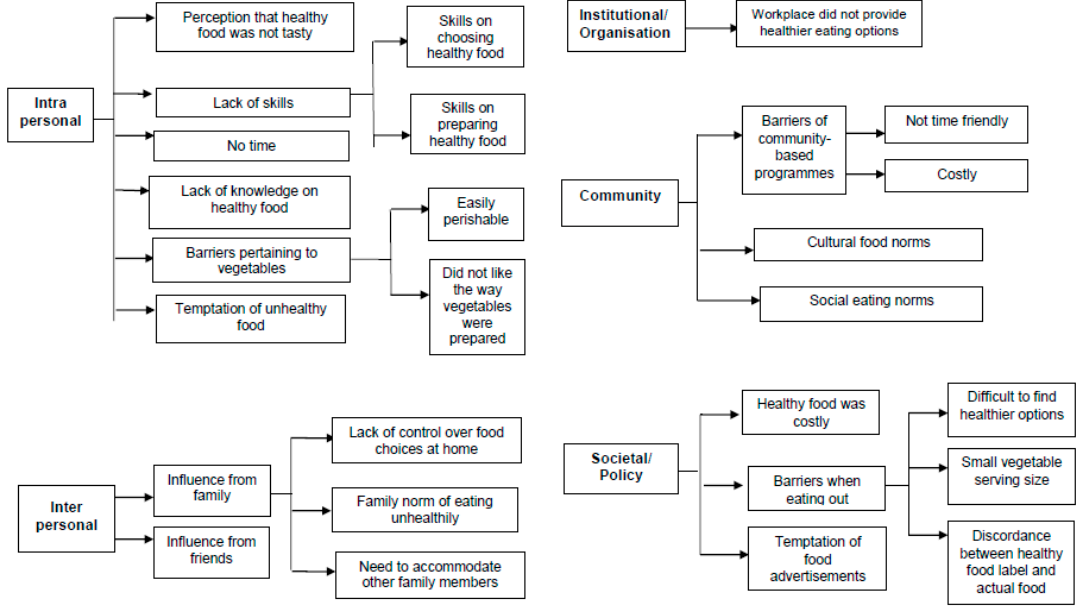
Figure 2. Themes and subthemes pertaining to reasons for not meeting My Healthy Plate recommendation.